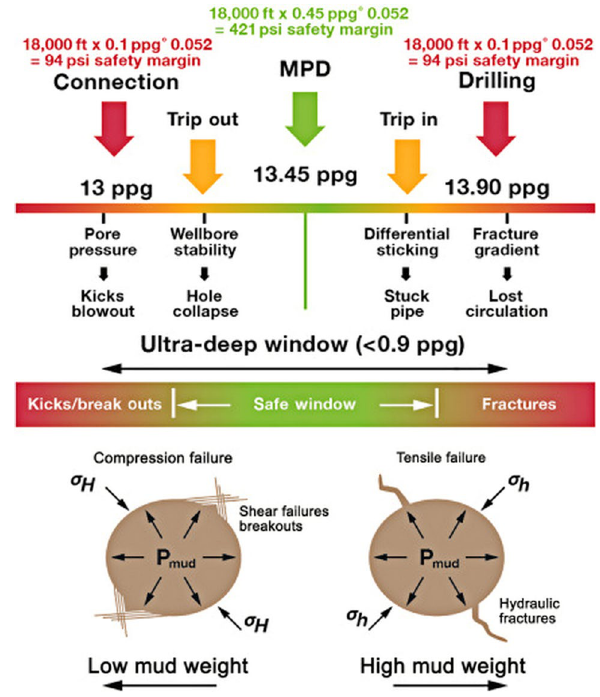
Fig. 16 Importance of mud weight management in narrow margin wells (William Abel